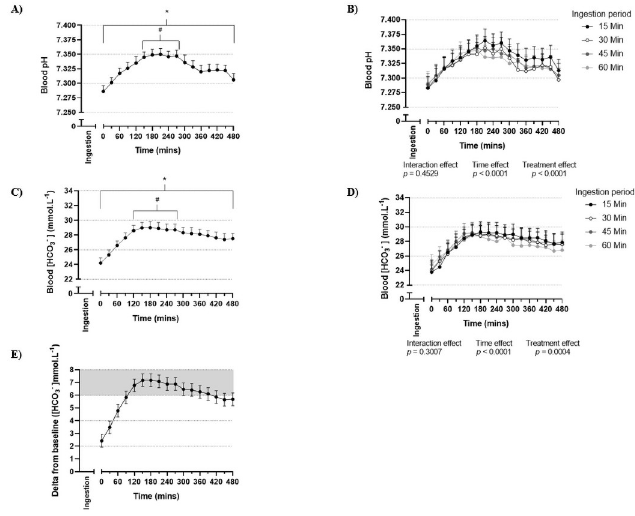
Fig 1. Blood pH and blood [HCO 3- ] after 500 mg.kg -1 BM sodium citrate ingestion. (A) Blood pH irrespective of ingestion period ( n = 16 participants, 4 sessions per participant, 64 total observations). (B) Blood pH following the completion of ingestion of sodium citrate over 15, 30, 45 or 60 min ( n = 16 participants per ingestion period). (C) Blood [HCO 3- ] (mmol.L -1 ) irrespective of ingestion period ( n = 16 participants, 4 sessions per participant, 64 total observations). (D) Blood [HCO 3- ] (mmol.L -1 ) following the completion of ingestion of sodium citrate over 15, 30, 45 or 60 min ( n = 16 participants per ingestion period). (E) Delta blood [HCO 3- ] (mmol.L -1 ) irrespective of ingestion period ( n = 16 participants, 4 sessions per participant, 64 total observations). Values are mean and 95% confidence intervals. Zero (0) value on the x-axis corresponds to the completion of sodium citrate ingestion. Grey (shaded) area in (E) indicates 6 mmol.L -1 above baseline. � elevated ( p < 0.05) compared to baseline. # time interval where values are above baseline ( p < 0.05) and not below gPeak (the maximum mean value, as ascertained from cumulative group data; p >